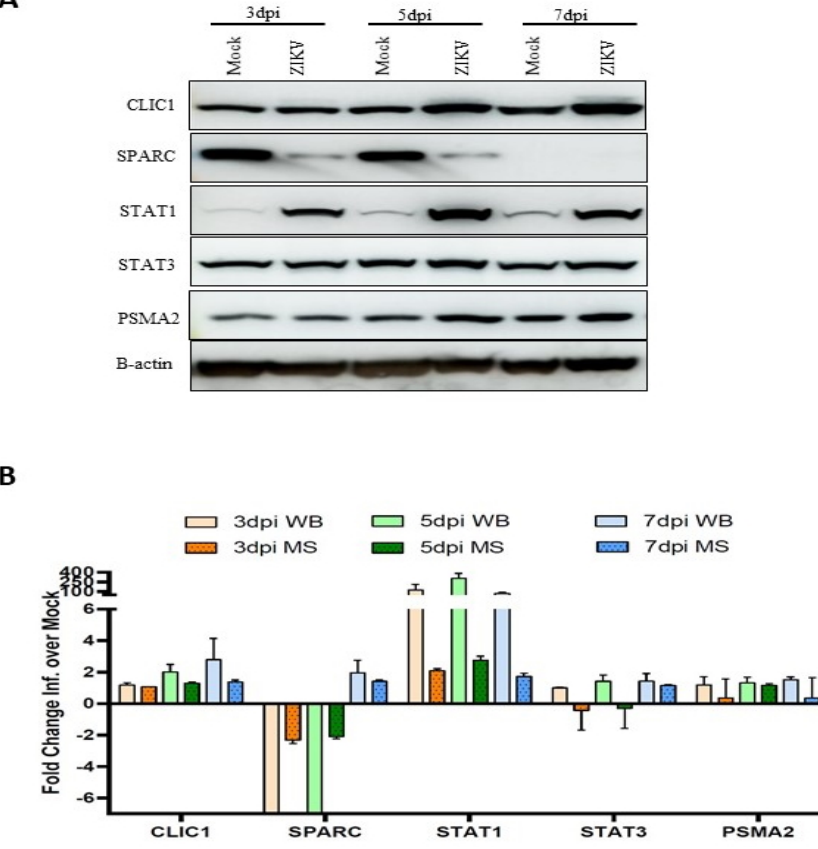
Figure 9. Western blot validation of proteomic changes detected by mass spectrometry (MS) analysis. Sertoli cell lysates were collected after ZIKV infection (MOI:3) at 3, 5 and 7 dpi. In total, 20 µ g of proteins were separated by SDS-PAGE gel electrophoresis. ( A ) Expression of CLIC1, SPARC, STAT1, STAT3 and PSMA2 were detected by Western blot using specific antibodies. ( B ) Expression values of the proteins from Western ‐ blot were quantified by ImageJ V1.8.0 from three replicates and plotted side ‐ by ‐ side to MS expression values. Expression of protein by Western blot was normalized to B ‐ actin expression. Abbreviations: dpi = Days post infection; WB = Western blot; MS = Mass spectrometry; ZIKV = Zika virus.